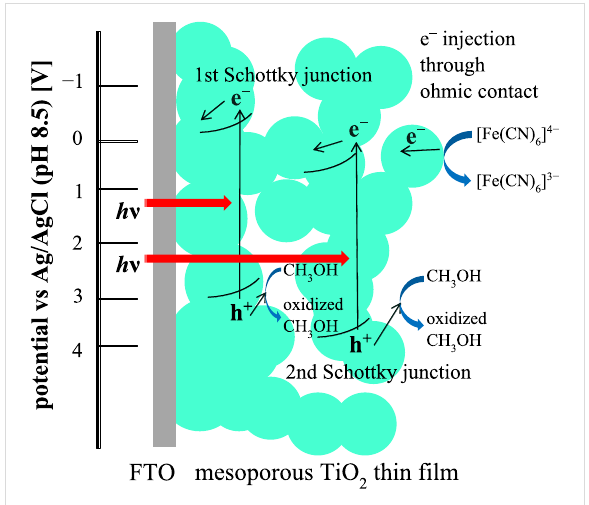
Figure 9: Schematic representation of a two-step Schottky junction/ ohmic contact behavior of a nanoporous n-TiO 2 thin